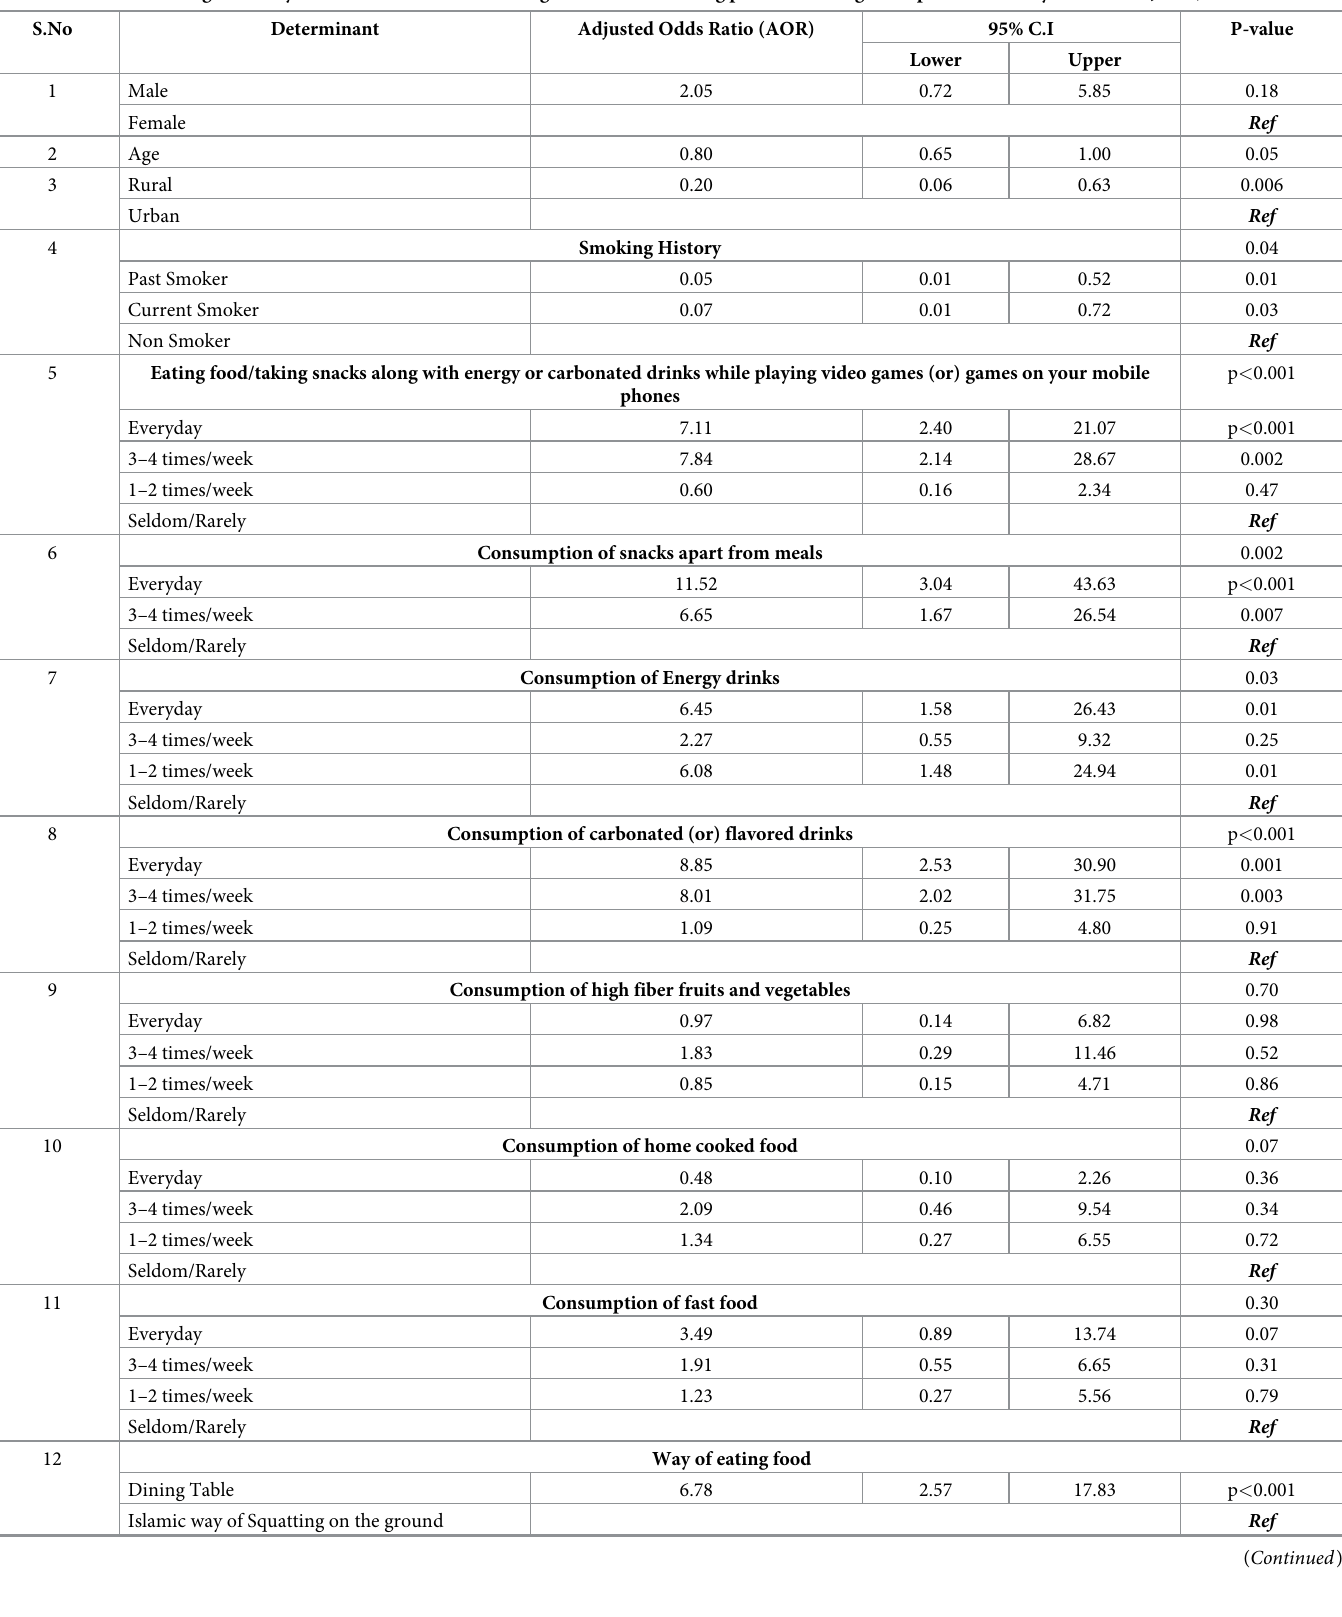
Table 3. Odds of overweight/obesity associated with selected eating behaviors and eating practices amongst sample of university students in Jazan, Saudi Arabia.